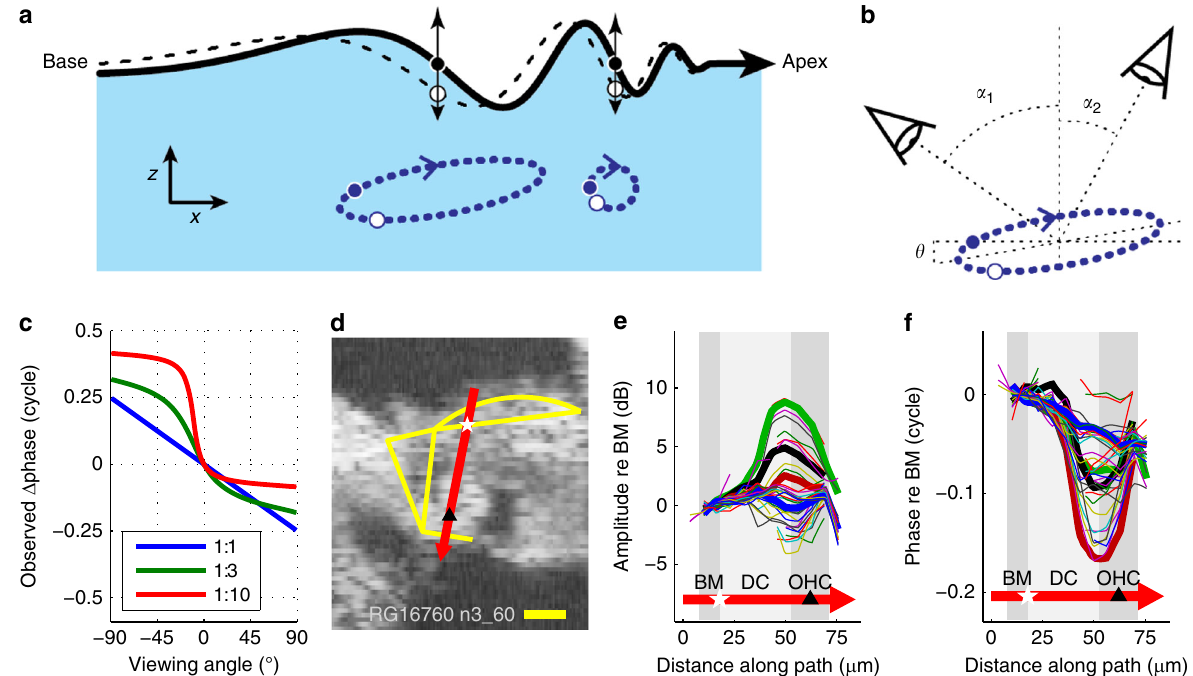
Fig. 8 Viewing-angle dependent ‘ relative-phase inversion ’ of hotspot motion. a Contrast between the purely transverse motion of the BM (vertical arrows) and the elliptical trajectories predicted for fl uid (and potentially structural) particles underlying a surface wave in the cochlea 1, 38, 39, 68 . The wave ’ s surface (the BM, black line) is pictured at two instants in time, separated by 1/8 cycle, with neighboring fl uid particle trajectories shown (using dashed blue lines) at two longitudinal positions. Coordinates: x = longitudinal; z = transverse. Longer wavelengths correspond to more elongated ellipses. The illustrated tilt of the ellipse ( θ in b ) may result from dissipation in either the fl uids 39, 68 or structures within the organ of Corti (see Supplementary Note 3). b , c Predicted effects of viewing angle on measured motion. In b , a “ negative ” angle α 1 views the wave traveling away from the measurement beam, with the measured (projected) motion of the ellipse phase-leading the transverse motion of the BM. By contrast, a “ positive ” viewing angle α 2 observes the same wave as traveling towards the beam, such that the measured motion of the ellipse phase-lags the transverse BM motion. c Exemplar relationships between viewing angle and the relative phase of the projected motion for ellipses with 10-degrees of baseline tilt ( θ , see b ) and longitudinal/transverse elongation factors of 1, 3, and 10 (see key). Computations, see Supplementary Note 4. d OCT image from one of two preparations where vibration measurements were made from positive angles of incidence ( α 2 in b ). Scale bar, 0.025 mm. e Pro fi les of vibration amplitude across the path shown by the red arrow in d . Each curve represents one frequency component in the multi-tone stimulus. Four speci fi c frequencies are identi fi ed by increased line width: 5.7 kHz (green), 10.6 kHz (black), 17.2 kHz (red), and 37.2 kHz (blue). f Corresponding phase data. All pro fi les are referenced to the vibrations observed at the BM location indicated with a white star in d . Gray patches indicate the different regions traversed by the red arrow, including the BM, Deiters ’ cells (DC) and OHCs (marked by the black triangle). Preparation RG16760, CF 40 kHz. Stimulus level 60 dB the bony wall of the apical cochlea. Both techniques reveal components of RL motion that are more broadly tuned, more extensively nonlinear, and up to 10× larger than BM motion.